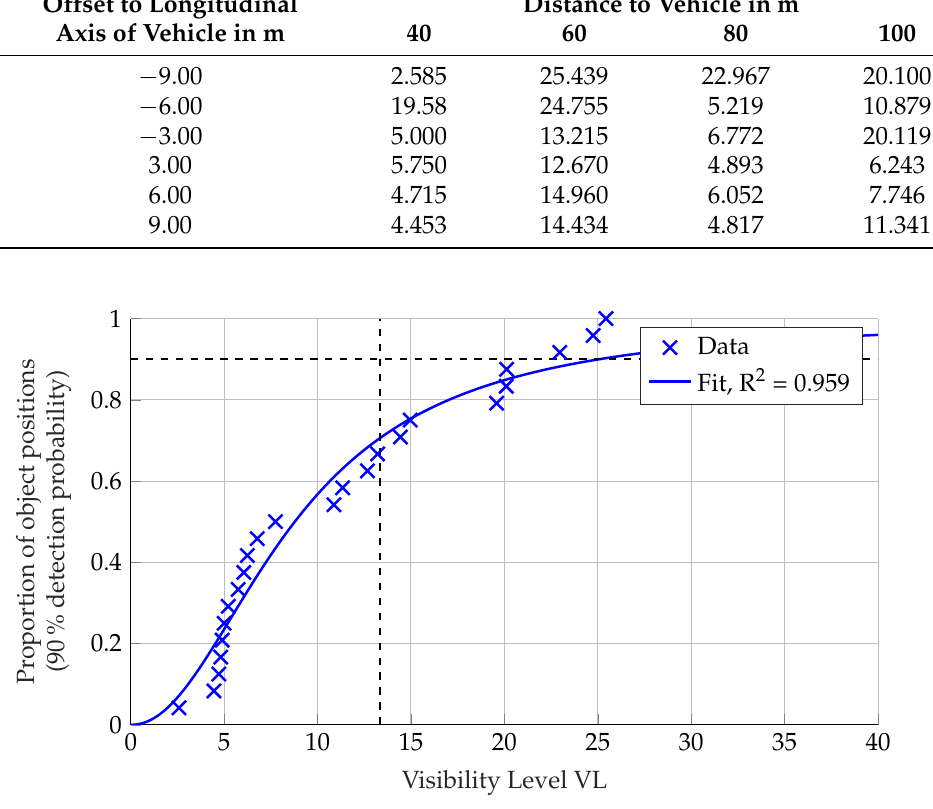
Figure 13. Relationship between the Visibility Level VL and the proportion of object positions on the closed test site at which the gray card is reliably detected; while a Visibility Level of 25 is required to reliably detect the gray card at 90% of the object positions, at the Visibility Level of 13.35 determined in the light tunnel, the gray card is detected at more than 70% of the object